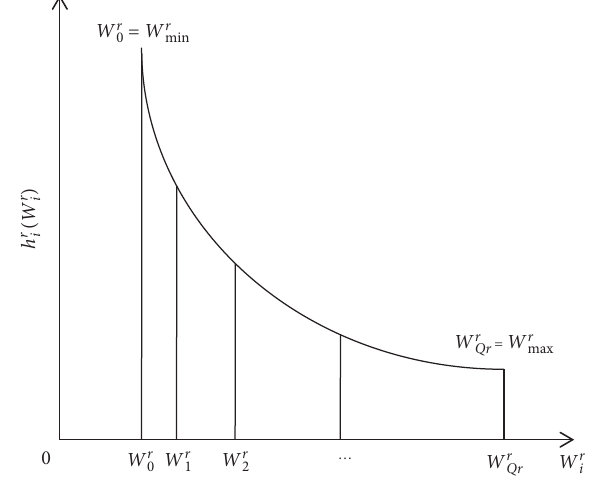
Figure 1: Discretization of the new decision